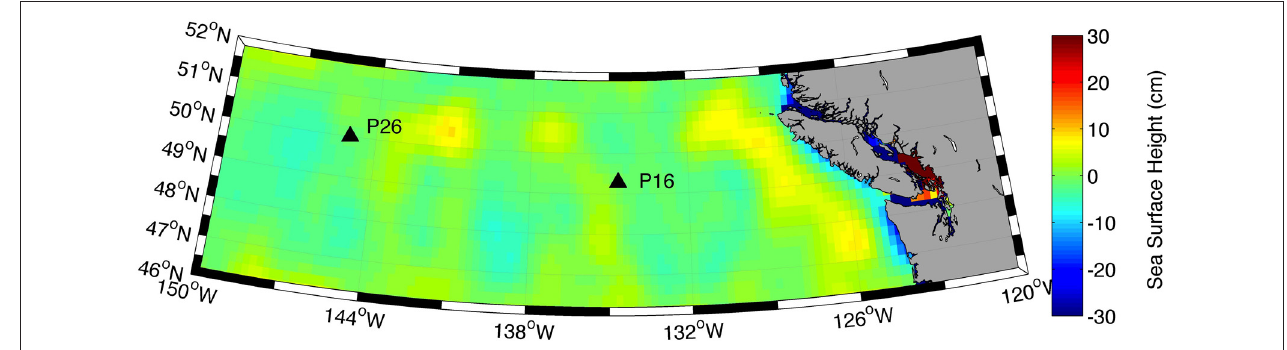
FIGURE 5 | Satellite derived sea surface height anomalies (cm) along the Line P transect for August 8, 2011. Data were retrieved from the Colorado Centre for Astrodynamics Research (CCAR) online